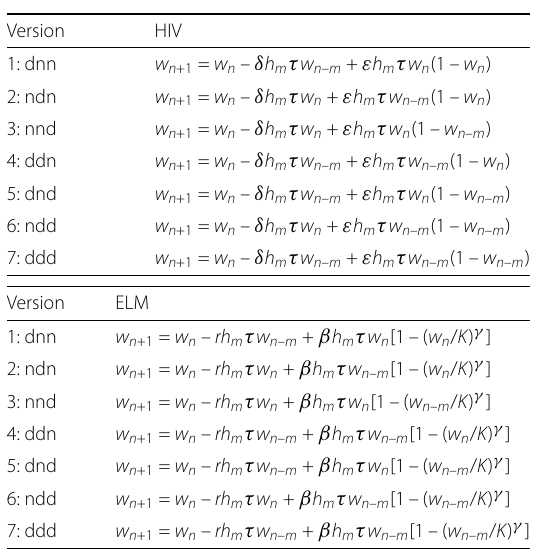
Table 2 Discrete time-delay equations for HIV and